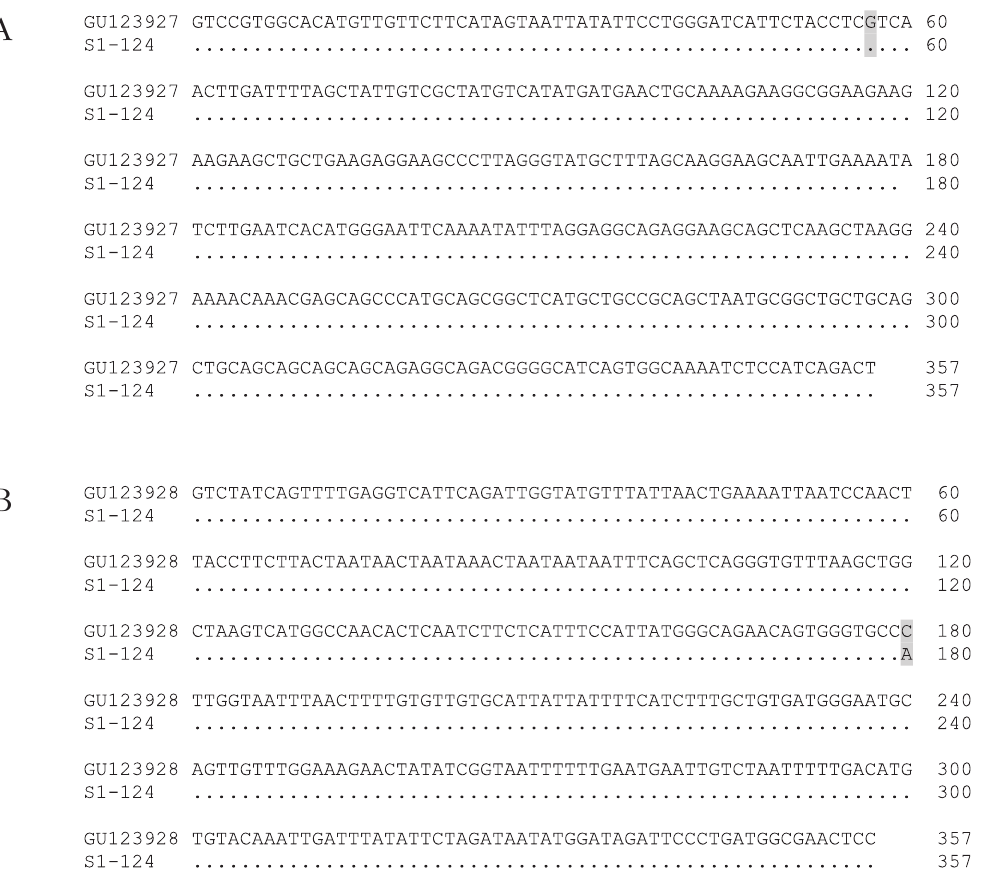
Fig. 4. – A: alignment of a part of the sequence of the voltage-gated sodium channel a-subunit gene, encompassing codon 419 (highlighted in yellow), from a pyrethroid-susceptible bed bug [Genbank access number: GU123927] and 124 adult bed bugs collected in the study. Nucleotides identical to those of the GU123927 sequence are indicated by periods; B: alignment of a part of the sequence of the voltage- gated sodium channel a-subunit gene, encompassing codon 925 (highlighted in yellow), from a pyrethroid-susceptible bed bug [Genbank access number: GU123928] and 124 adult bed bugs collected in the study. Nucleotides identical to those of the GU123928 sequence are indicated by